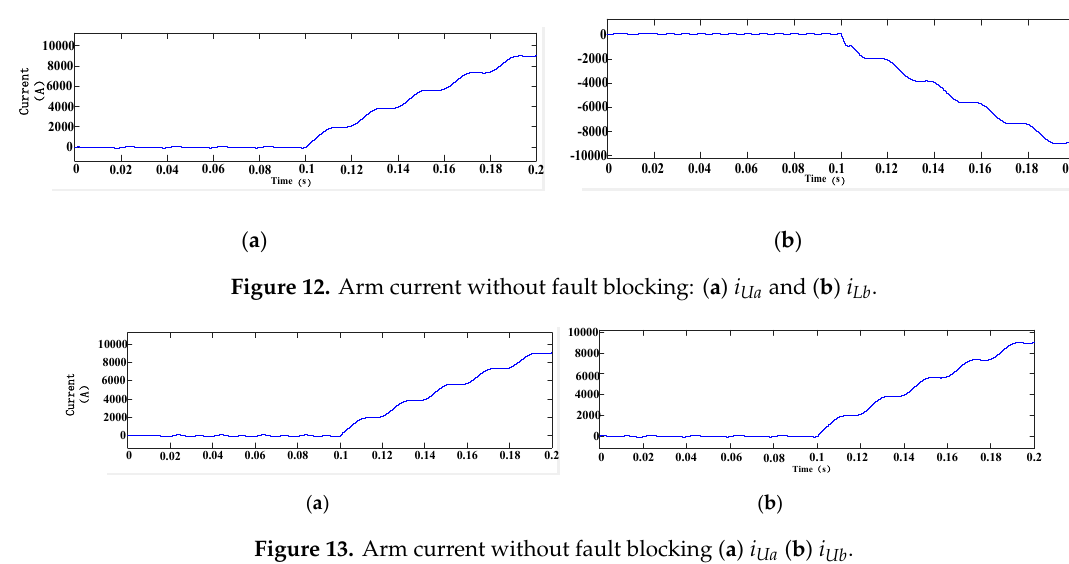
Figure 11. Arm current 𝑖 (cid:3014)(cid:3028) without fault blocking.